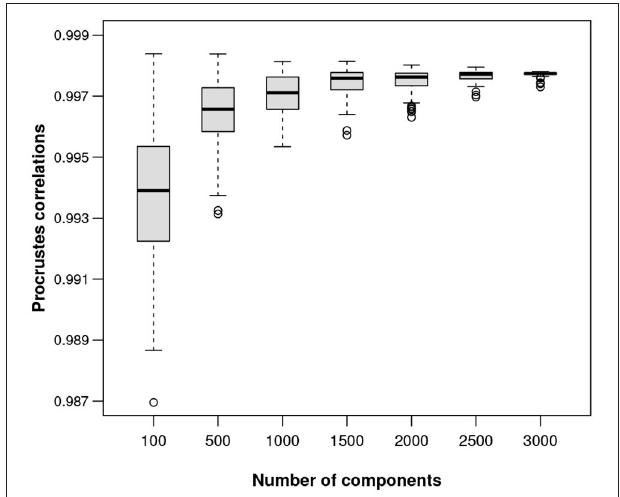
FIGURE 7 | Boxplots of Procrustes correlations based on 100 random samples of the components (columns) of the Mice data set, for each of 100 up to 3,000